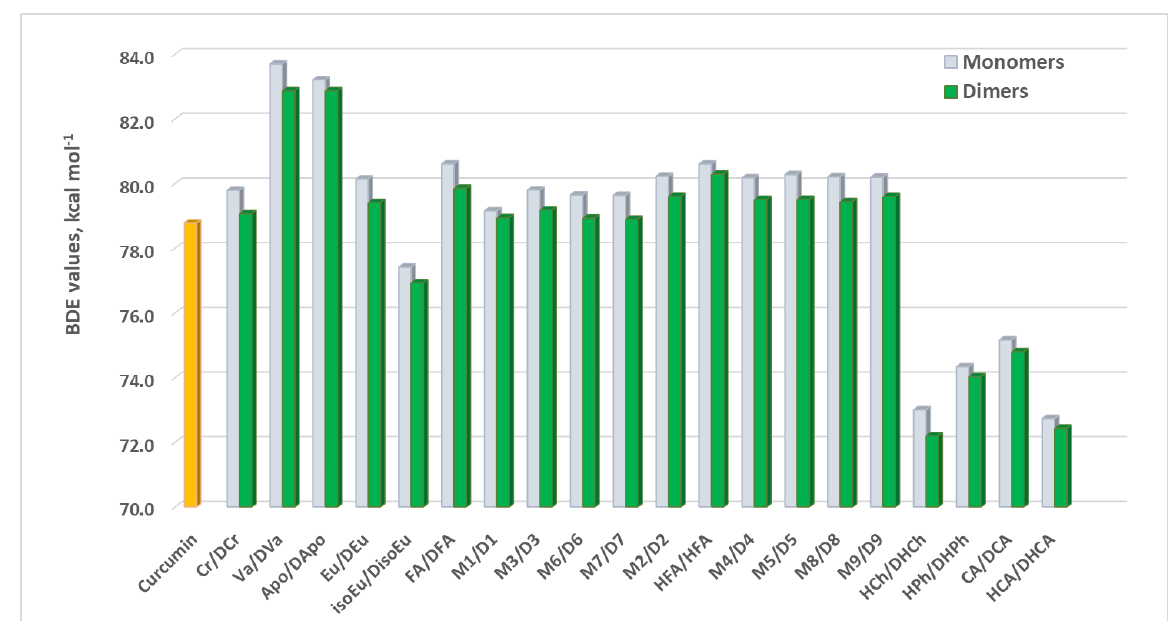
Figure 6. DFT calculated BDEs for curcumin, natural and synthetic antioxidants. Curcumin: characterized by BDE value of 78.8 kcal mol − 1 , a relatively high value. Monomers Cr , Va , Apo , Eu , iso-Eu , FA , M1 , M3 : characterized by values from 77.4